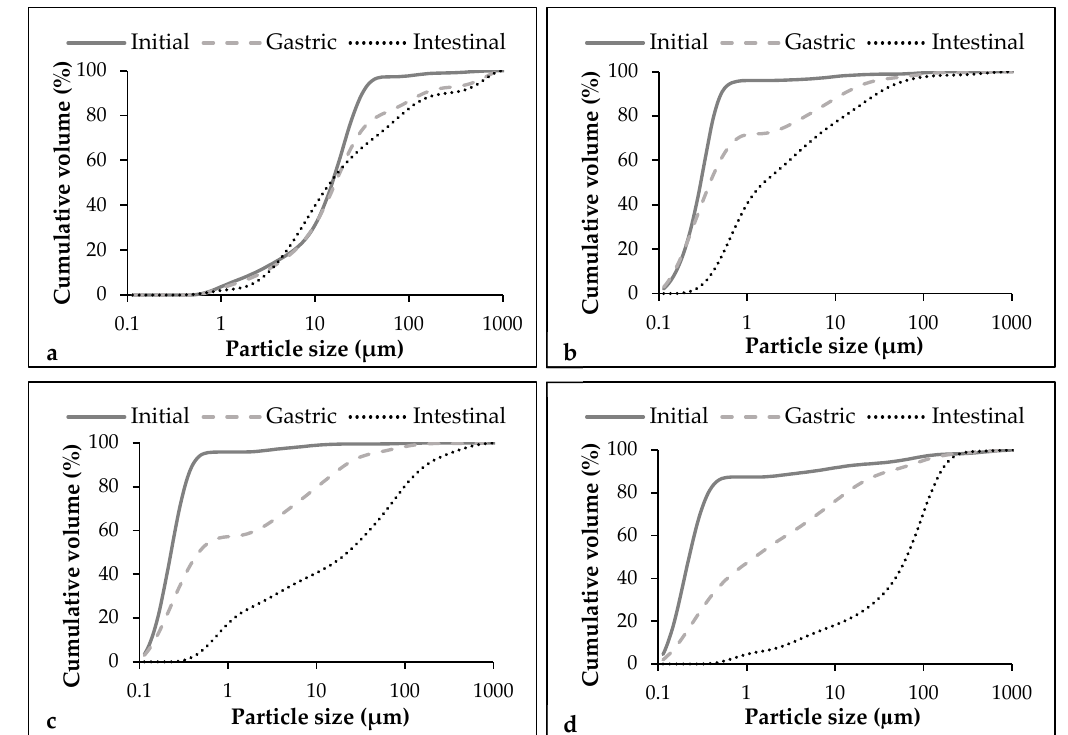
Figure 1. Particle size distribution of coarse emulsion and nanoemulsions with different pectin concentrations (0%, 1%, and 2%) at different phases of the in vitro digestion. ( a ) Coarse emulsion without pectin; ( b ) Nanoemulsion without pectin; ( c ) Nanoemulsion with 1% of pectin; ( d ) Nanoemulsion with 2% of pectin.